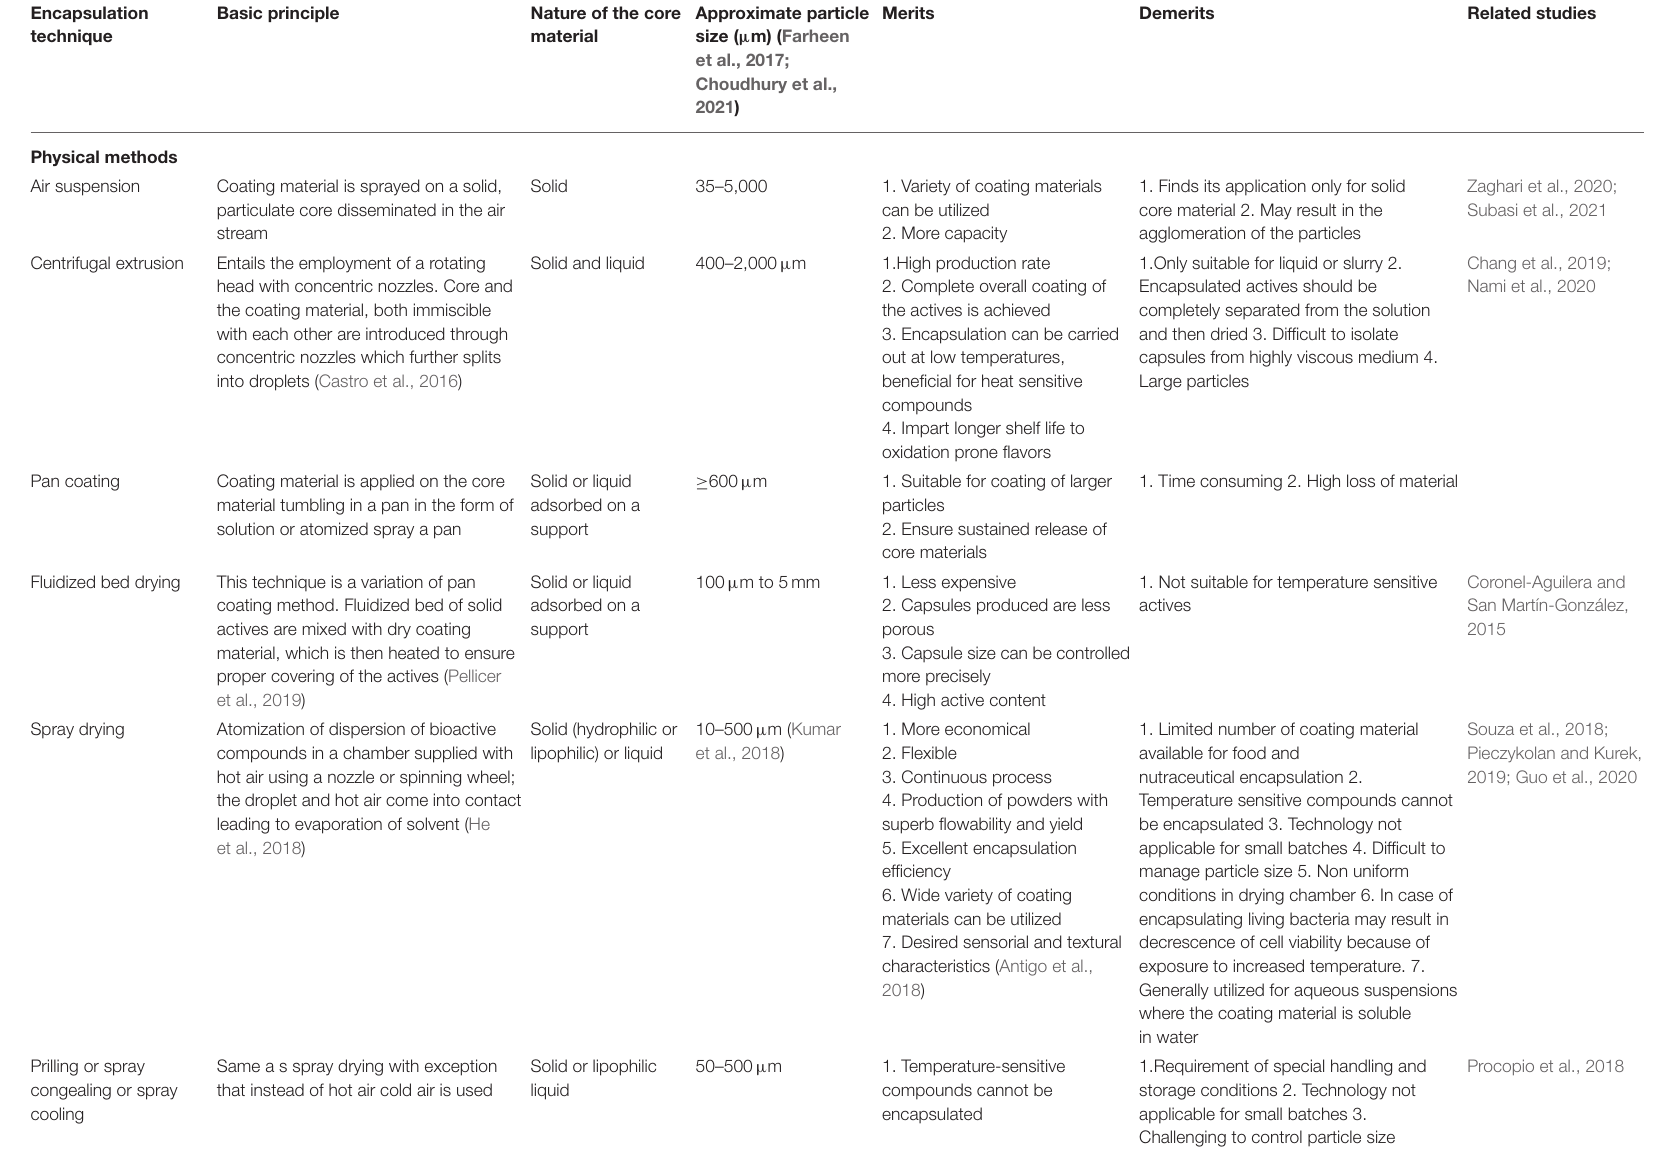
TABLE 1 | Overview of encapsulation techniques, basic principle, nature of the core material, particle size, merits, and